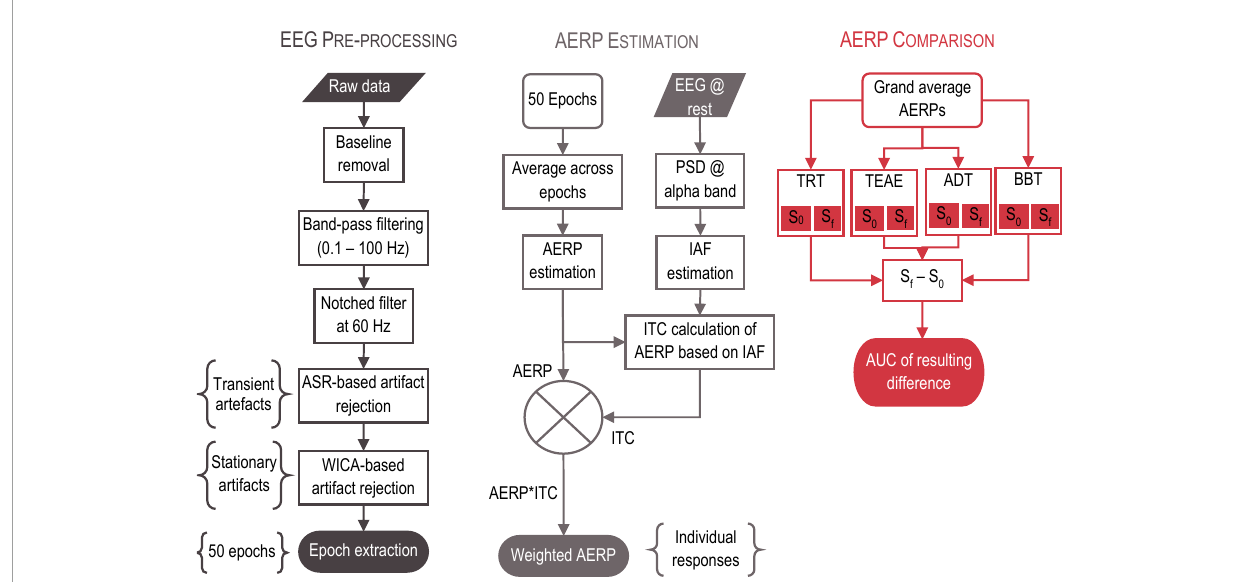
FIGURE6 EEG signal analysis. The analysis was performed in three stages: (1) Pre-processing of EEG signals, (2) AERP estimation and validation based on ITC, and (3) AERP grand average per acoustic therapy and session.